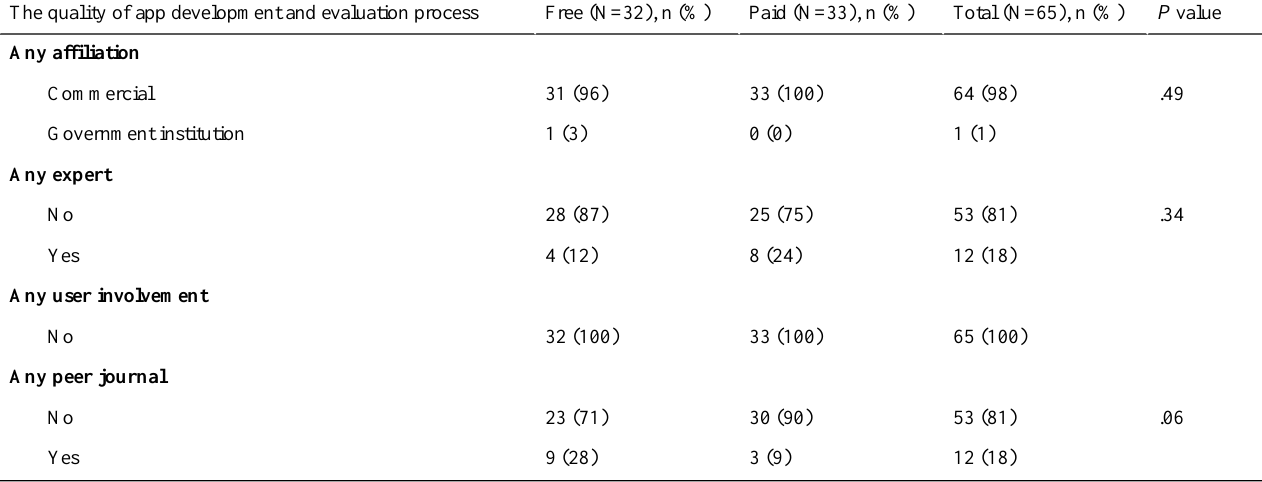
Table 6. Descriptive data for the quality of app development and evaluation process: organizational affiliation, expert and user involvement, and evidence of evaluation in peer-reviewed